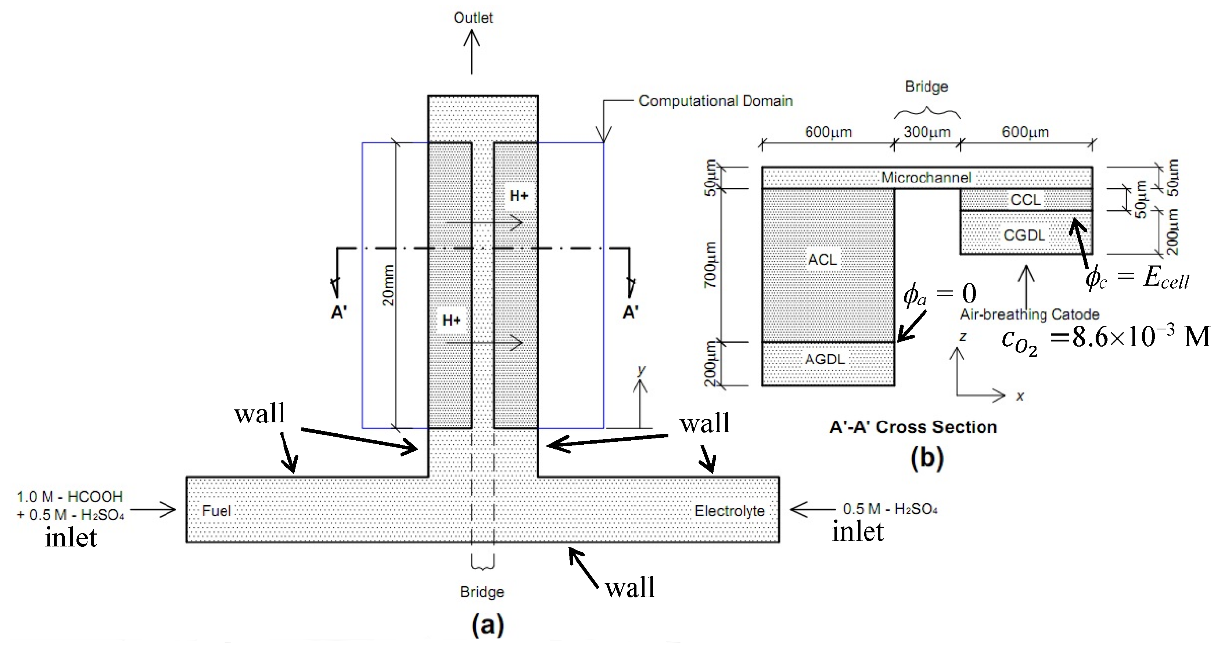
Figure 1. Schematic illustration of the computational domain and geometrical structure of the T-shaped air-breathing DFAMFC model: ( a ) the top view; ( b ) the sectional view. While sufficient oxygen supply from the air is chosen as an oxidant, the electrolyte